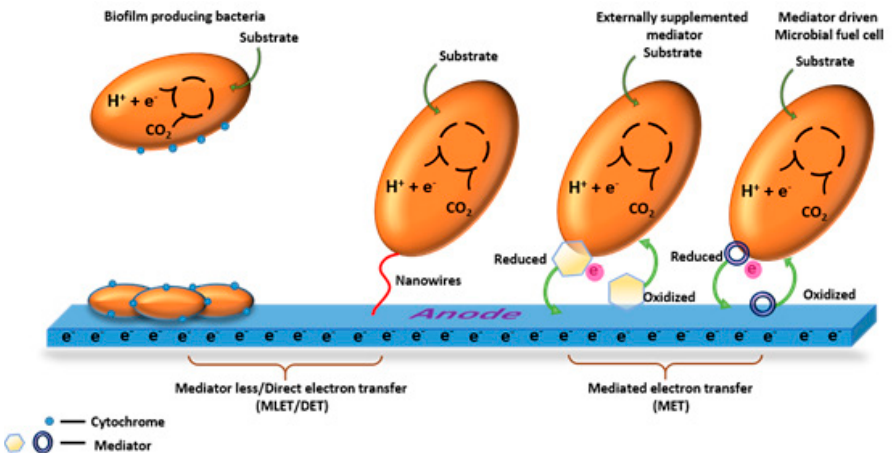
Fig. 1. Illustration of different methods of electron transfer in MFCs, mediator -less/direct electron transfer (DET) and mediated electron transfer (MET) [Source: Rabaey et al ., 2004; Rabaey et al ., 2005; Rabaey et al ., 2007; Schroder, 2007; Logan,